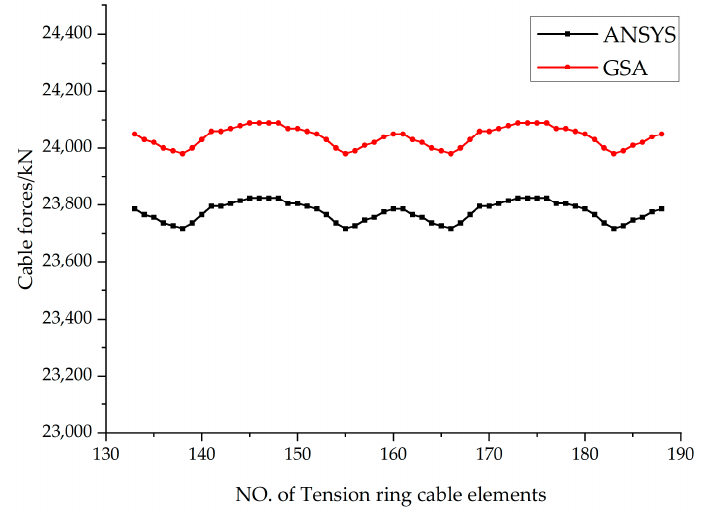
Figure 14. Comparison curves of tension ring cable forces (kN).